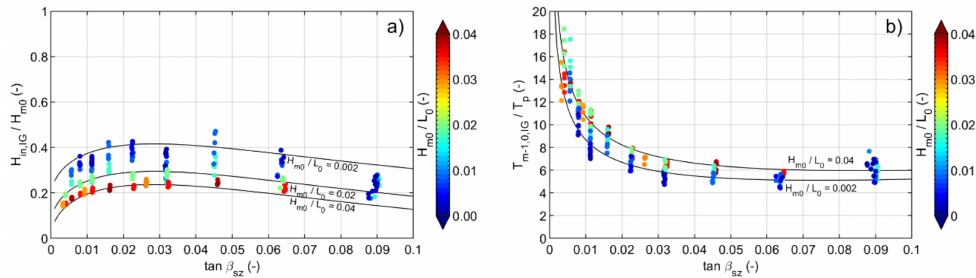
Figure 7. Effect of surf zone slope and offshore wave steepness on incoming infragravity wave height ( a ) and infragravity wave period T m -10, in , IG ( b ) near the shoreline. Solid lines are the empirical fit for various offshore wave